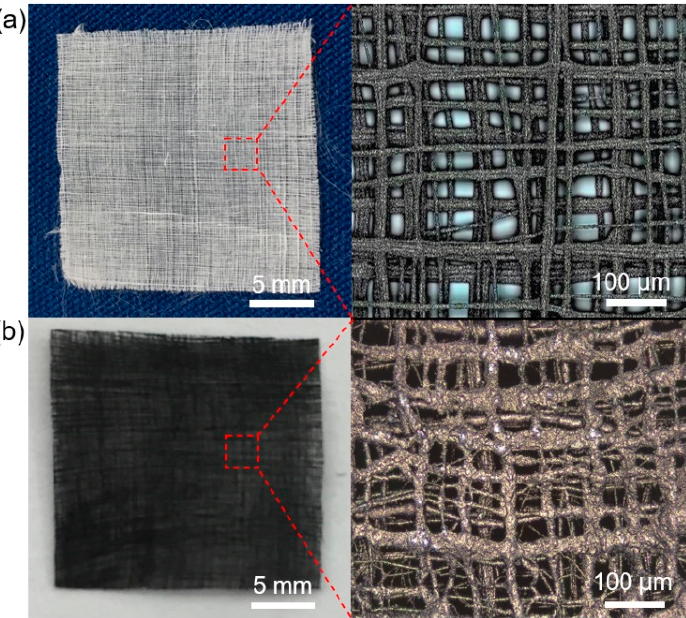
Figure 3. Optical images of the PVDF film and MoS 2 -PVDF composite film. ( a ) Optical images of the PVDF film with the dimension of 2 cm × 2 cm. ( b ) Optical images of the MoS 2 -PVDF composite film.